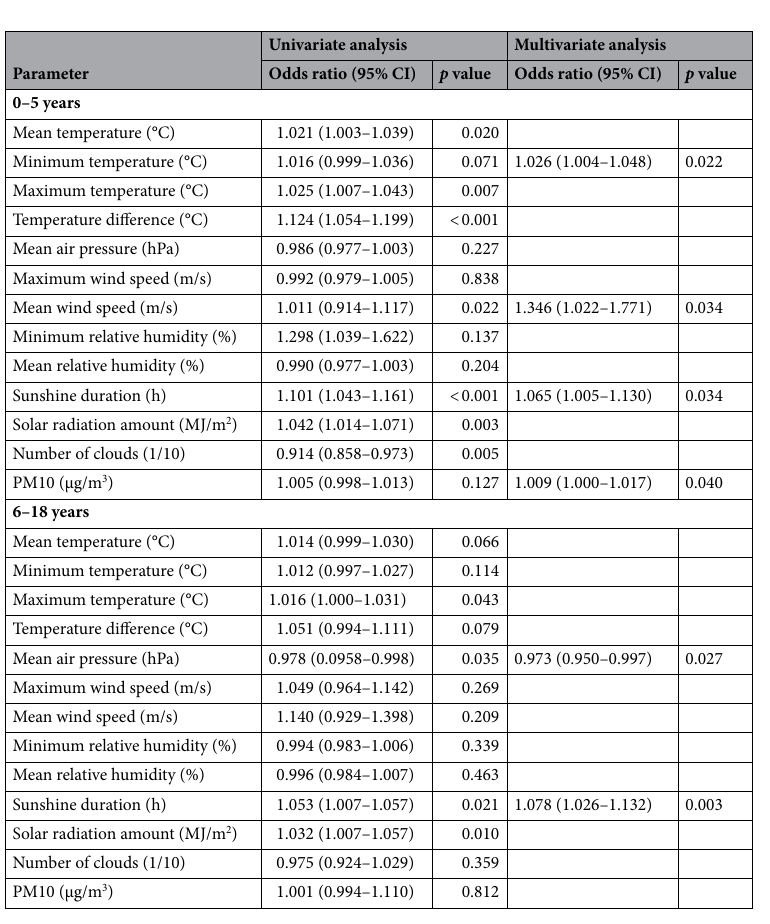
Table 2. Multivariate logistic regression analyses of meteorological factors, including PM10 concentration and the number of hospital epistaxis presentations per day between the 0–5- and 6–18-year age groups. CI: confidence interval, PM10: particulate matter measuring ≤ 10 μm in